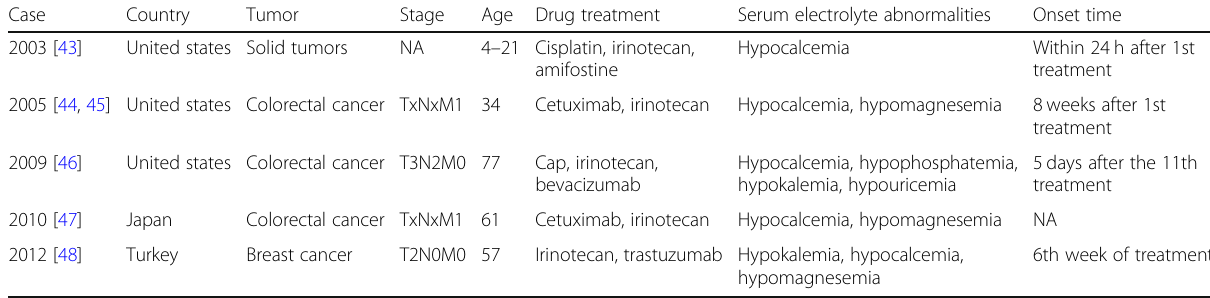
Table 3 Reported cases showing a positive association between irinotecan and hypocalcemia Case